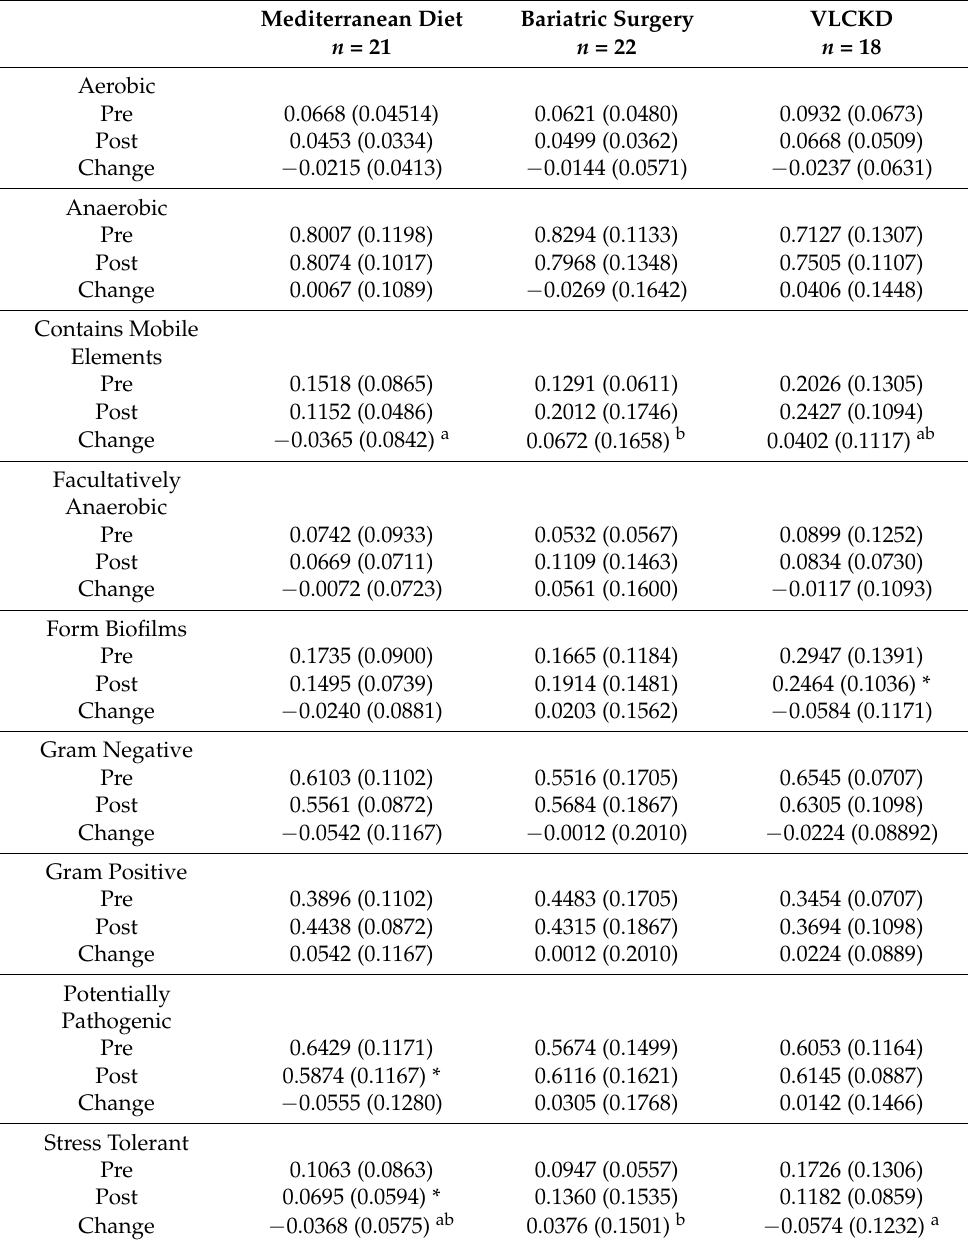
Table 2. Organism-level microbiome phenotype